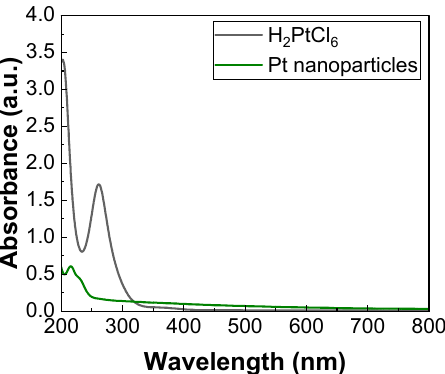
Figure 1. UV-vis spectra for H 2 PtCl 6 (black) and the reduced Pt nanoparticles (green) in aqueous solution. The Pt nanoparticle solution spectra are taken two hours after NaBH 4 addition.